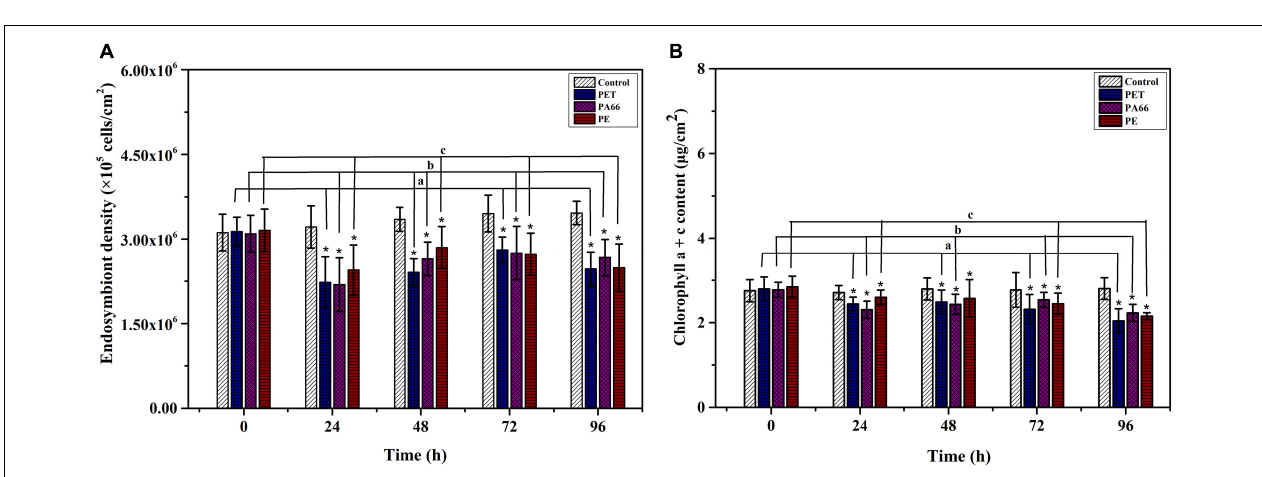
FIGURE 2 | Effects of microplastics exposure on the density and chlorophyll content of endosymbiont in corals. Density variation of the endosymbiont in Acropora pruinosa after different MPs exposure (A) . Content variation of the chlorophyll a + c (B) . Histogram data represent means and error bars represent standard deviations ( N > 3). Asterisk (*) represent a significant difference from normal (* p <